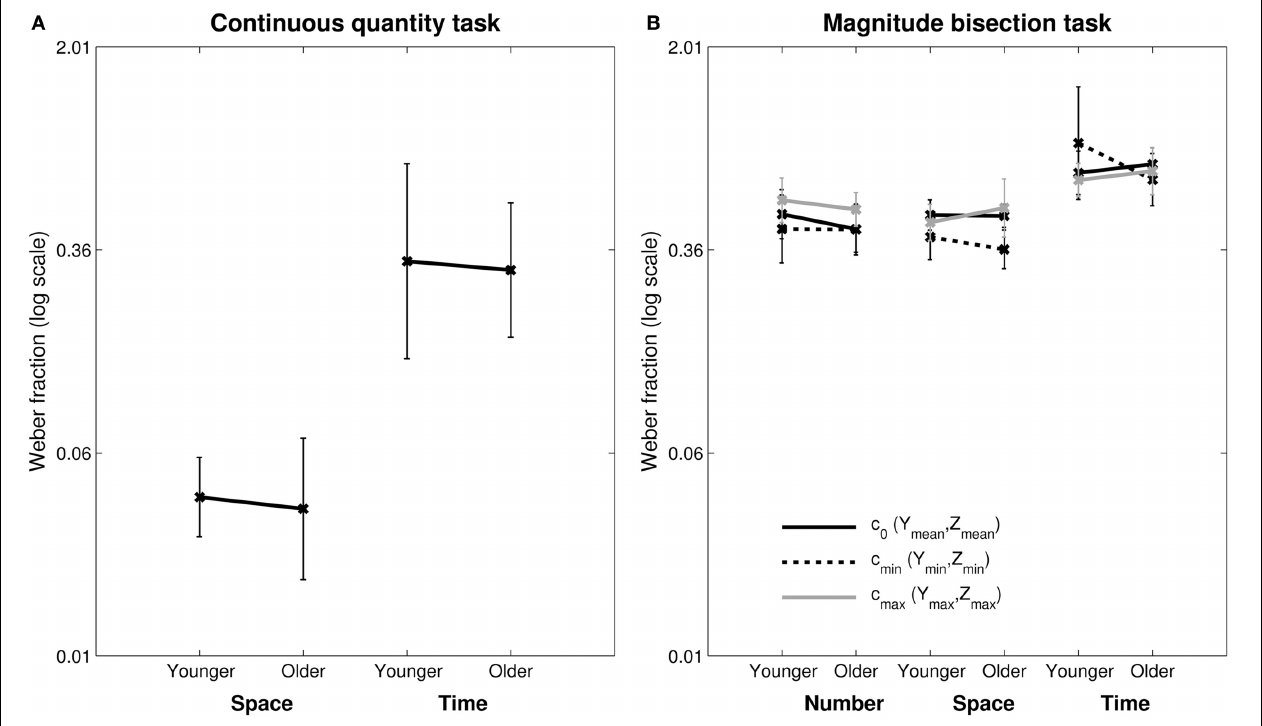
FIGURE 2 | Weber Fractions ( wf ) for the continuous quantity tasks (A) and the magnitude bisection tasks (B). In the magnitude bisection tasks wf are presented in the three experimental conditions